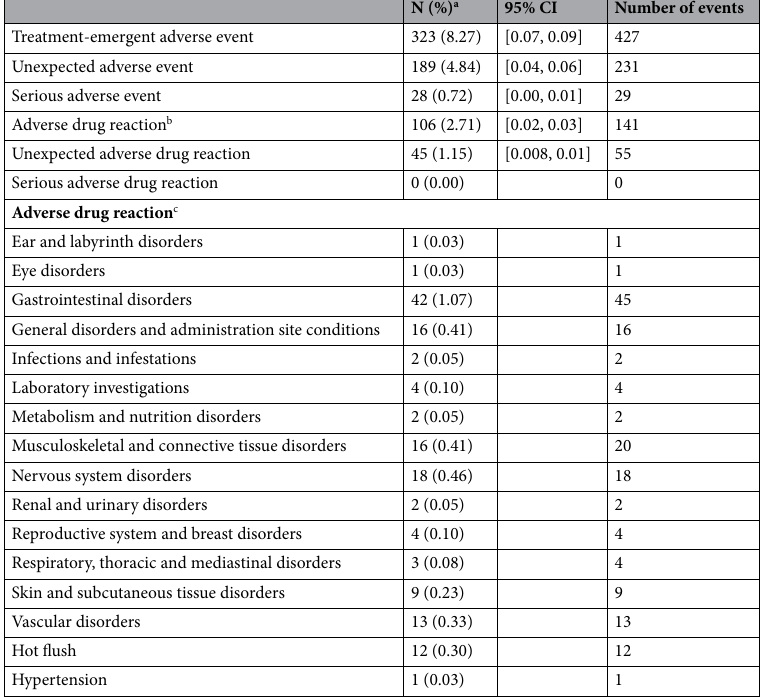
Table 4. Safety profile (n = 3,907). CI confidence interval. a Overlapping count. b Adverse drug reaction: certain, probable/likely, possible, conditional/unclassified, unassessable/unclassifiable. c Coding dictionary: MedDRA ver. 20.1.